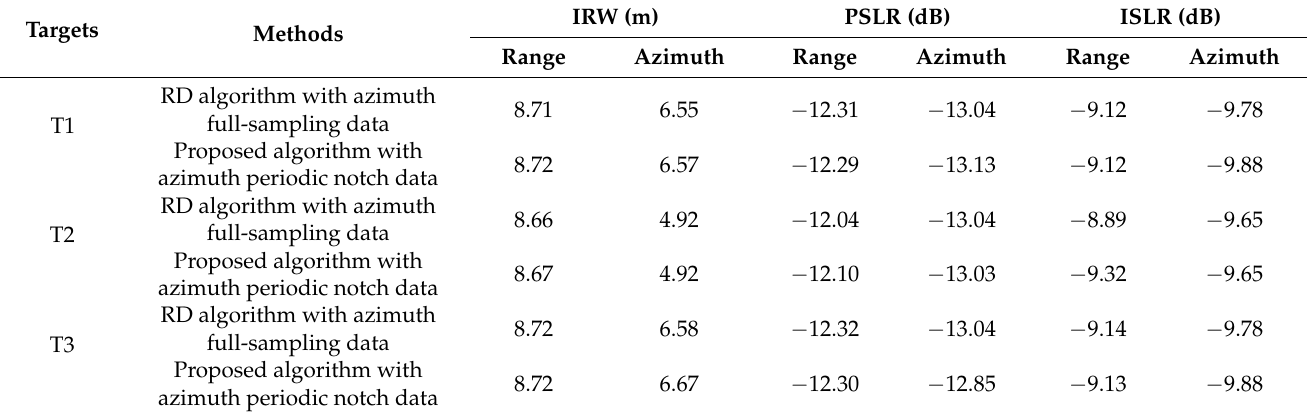
Table 2. Focusing quality parameter analysis of three point